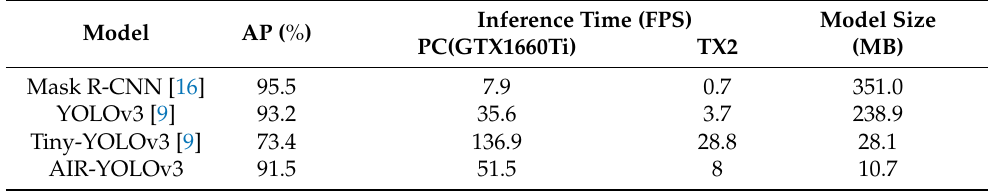
Table 3. Comparison of the AIR-YOLOv3 model on PC and TX2.